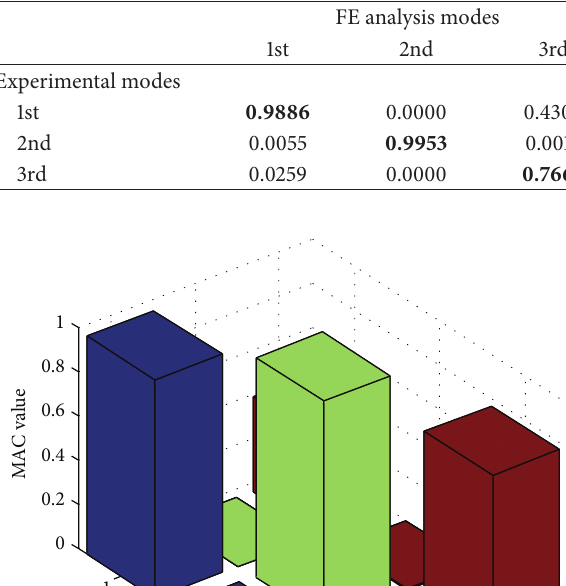
Table 9: MAC values (7 DOF anal. and exp.).